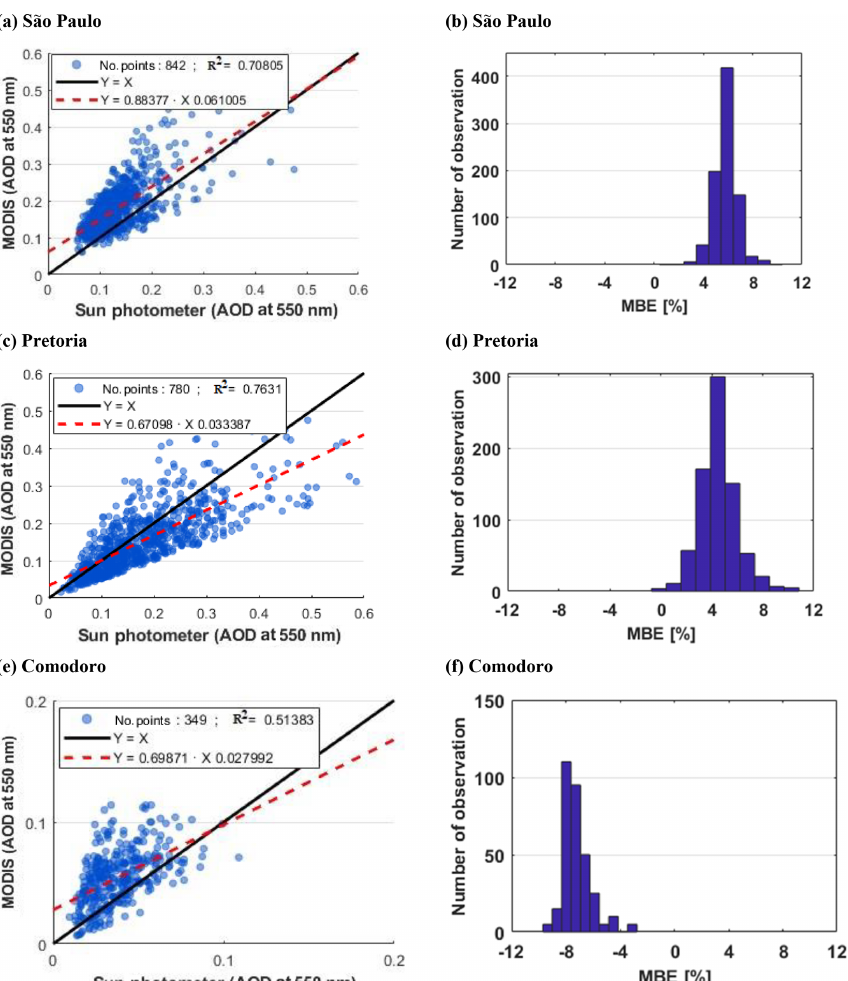
Figure 8. Correlation of AOD daily mean observations (550nm) between sun photometer and MODIS observations during the entire period of available data at (a, b) São Paulo, (c, d) Pretoria, and (e, f) Comodoro. The histograms show the mean bias error (MBE) of the two data sets against the number of observations for each